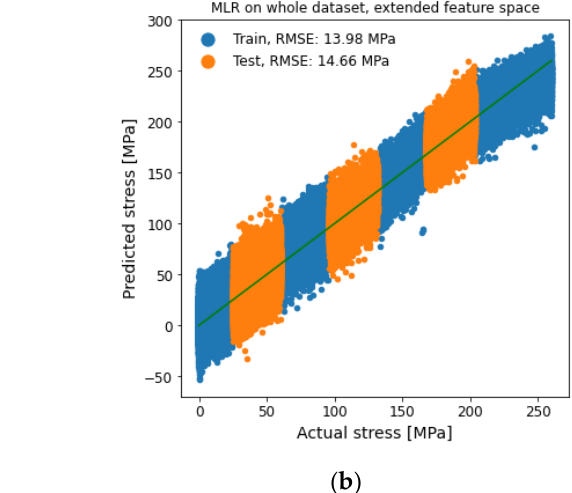
Figure 13. MLR for stress determination on whole dataset. ( a ) 21-dimensional feature space and ( b ) extended feature space.